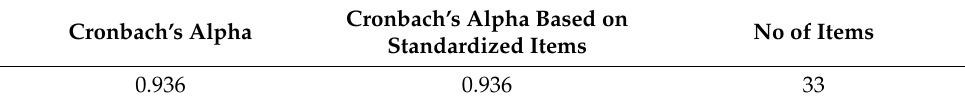
Table 1. Cronbach’s Alpha.